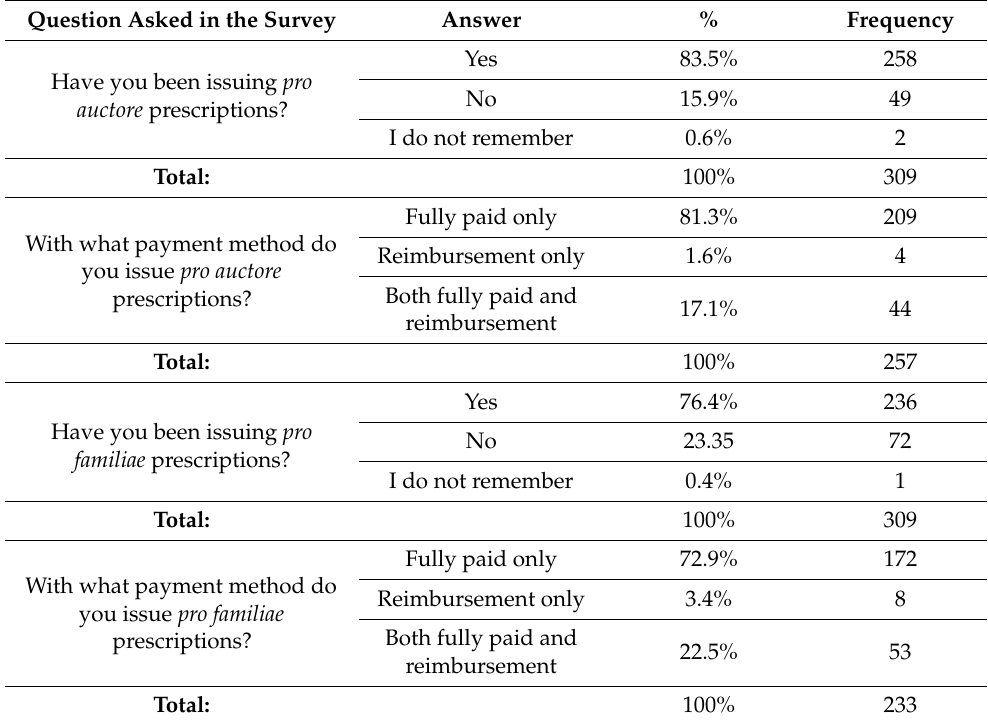
Table 2. Distribution of respondents’ answers to questions about the pro auctore and pro familiae prescriptions